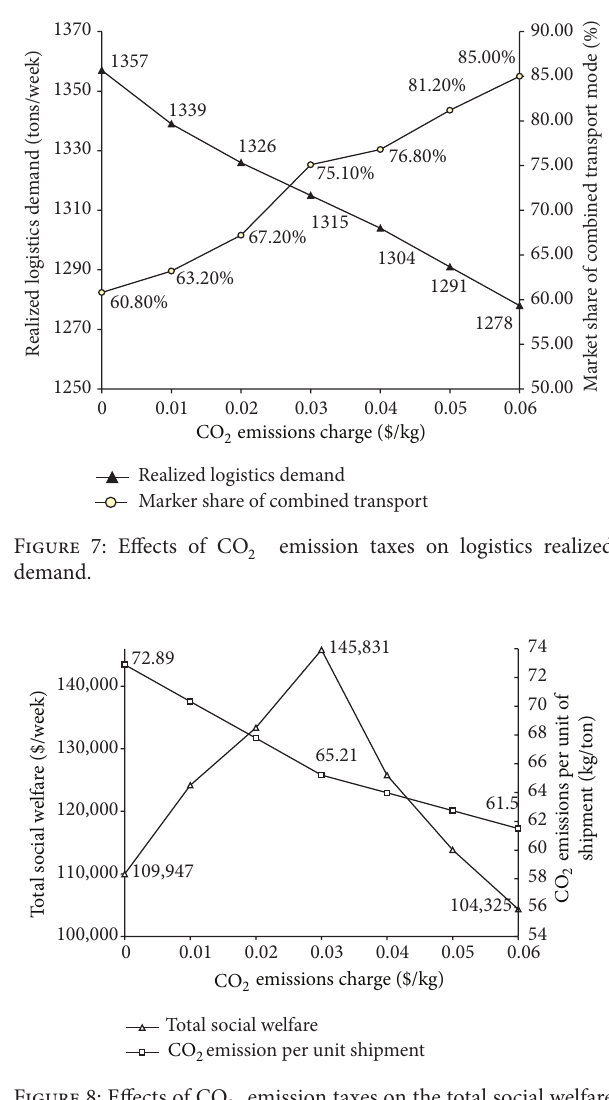
Figure 8: Effects of CO 2 emission taxes on the total social welfare unit shipment CO 2